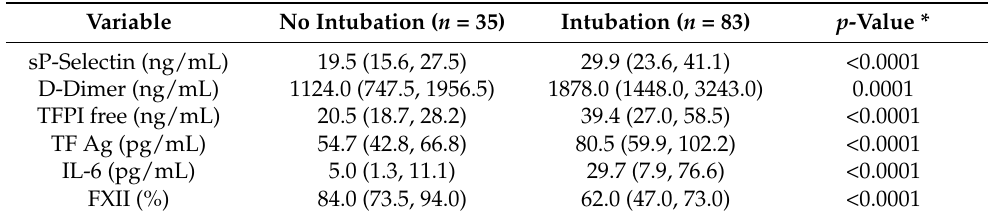
Table 3. Top six feature combination associated with intubation risk at patients with COVID-19 admitted in ICU. Continuous data are presented as medians